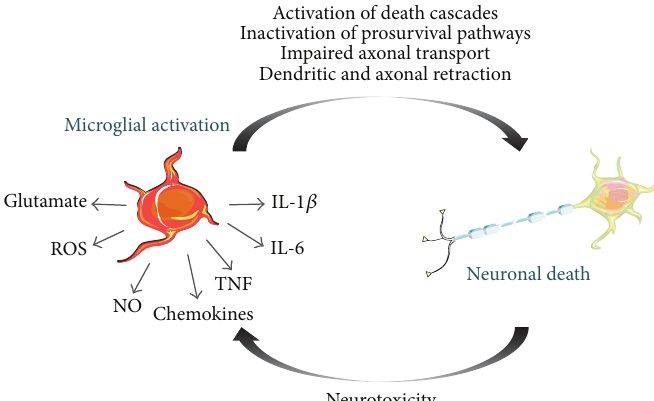
Figure 3: Relationships between microglial activation and neuronal cell death. In response to changes in the environment, microglia change to a more reactive phenotype, characterized by alterations in cell morphology, gene expression and proinflammatory mediators release. The sustained release of inflammatory factors perpetuates the neuroinflammatory process further activating microglia, which release proinflammatory and neurotoxic factors, contributing to neuronal dysfunction and to